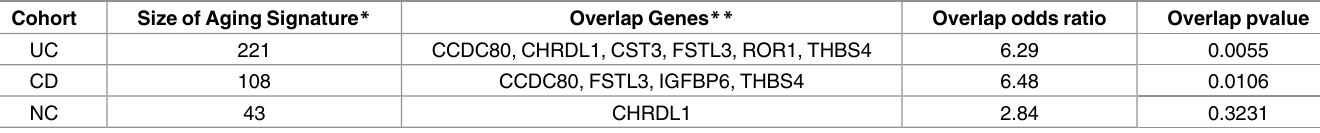
* Number of proteomic traits with nominal pvalue (cid:20) 0.05 of positive association with aging. ** Genes overlappingwith aging signature reported by Menni et al [4]; all 10 genes in Menni et al [4] were reported as having a positive association with aging.